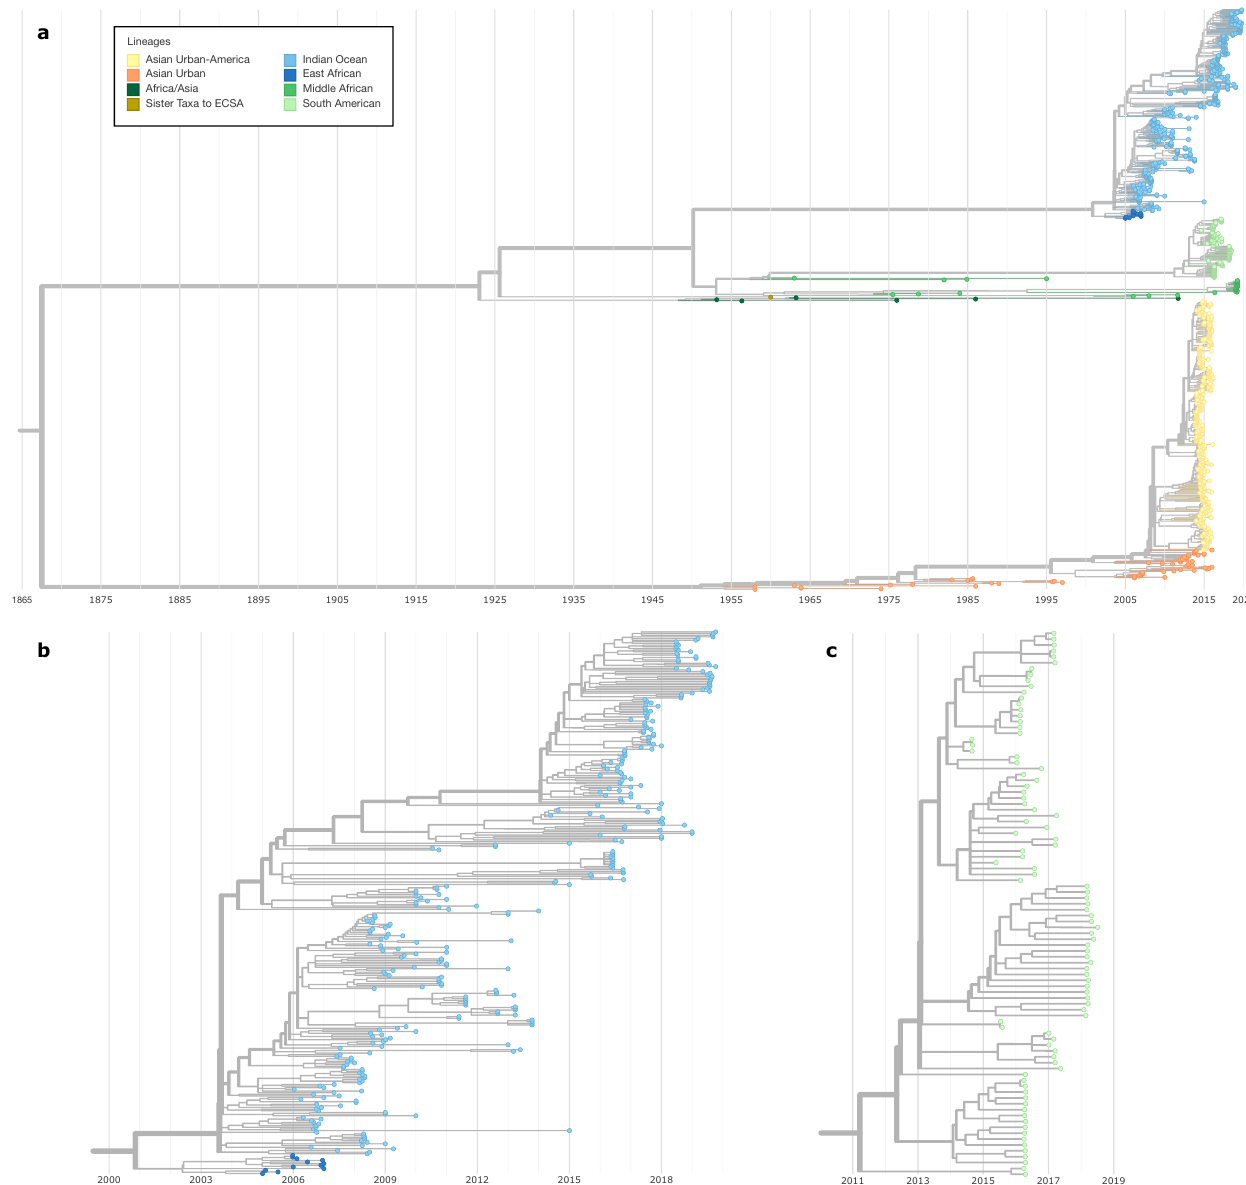
Figure 1. Nexstrain time-resolved maximum likelihood phylogeny of CHIKV. The overview tree in ( a ) comprises the major lineages except the West Africa lineage. The latter is located ancestral to all other clades with an inferred time of the most recent common ancestor (TMRCA) date in 1645 (confidence interval 1625–1667, data not shown). ( b ) shows a more detailed view of the clade encompassing the East African (dark blue) and the Indian Ocean Lineage (light blue). ( c ) shows the subtree containing the South American lineage. A detailed view of the Asian Urban-American lineage is shown in Figure